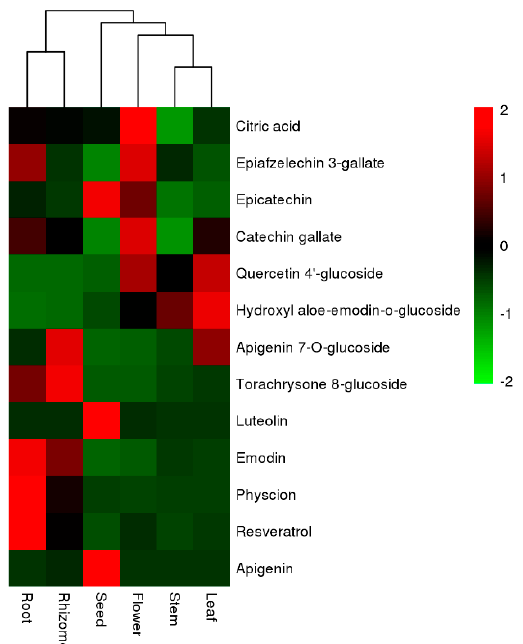
Figure 5. The relative contents of thirteen markers in different tissues of P. cuspidatum . The contents of each compound was normalized as a relative content. The heatmap was exhibited using a hierarchical clustering algorithm based on the normalized average abundance.